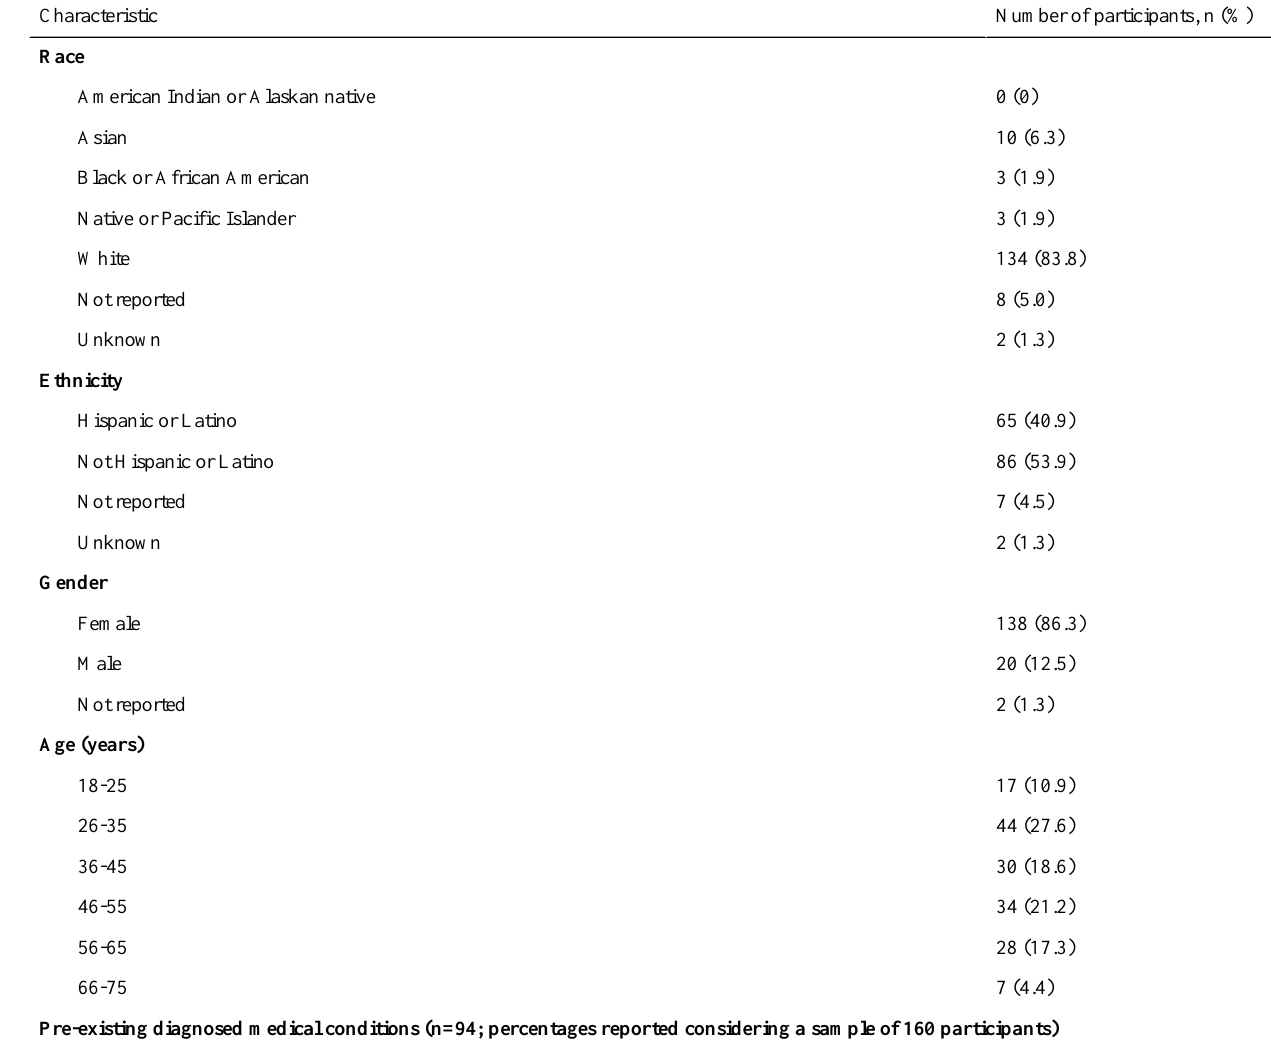
Table 1. Demographic characteristics of the survey participants